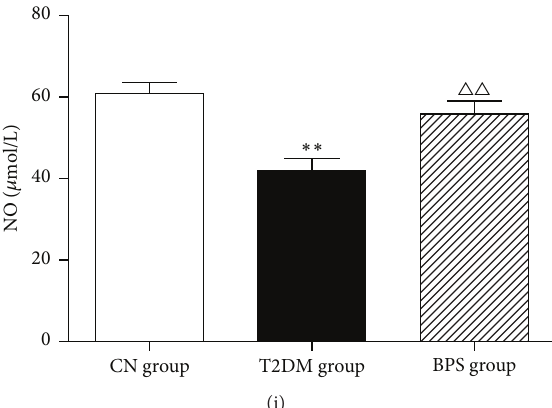
Figure 4: IL-6 (a), hs-CRP (b), TNF- 𝛼 (c), ET-1 (d), SOD (e), MDA (f), GSH (g), MPO (h), and NO (i), in CN group rats, T2DM group rats, and BPS group rats. As bar graph, data are mean ± SD of 6 rats. ∗ 𝑃 < 0.05 and ∗∗ 𝑃 < 0.01 T2DM group and BPS group versus CN group rats and 󳵻 𝑃 < 0.05 and 󳵻󳵻 𝑃 < 0.01 BPS group versus T2DM group. Table 6: Immunohistochemical expression of CD31 and collagen type IV in kidney tissues of rats in experiment ( 𝑛 = 6 , 𝑋 ± 𝑆 ). Integrated optical density (IOD) CN group T2DM group BPS group CD31 2546.83 ± 253.05 7485.00 ± 289.74 ∗∗ 5467.50 ± 422.93 ∗∗△△ Collagen type IV 2283.67 ± 554.55 8418.00 ± 738.00 ∗∗ 7185.50 ± 482.97 ∗∗△△ ∗ 𝑃 < 0.05 and ∗∗ 𝑃 < 0.01 T2DM group and BPS group compared with CN group rats and △ 𝑃 < 0.05 and △△ 𝑃 < 0.01 BPS group compared with the T2DM group.